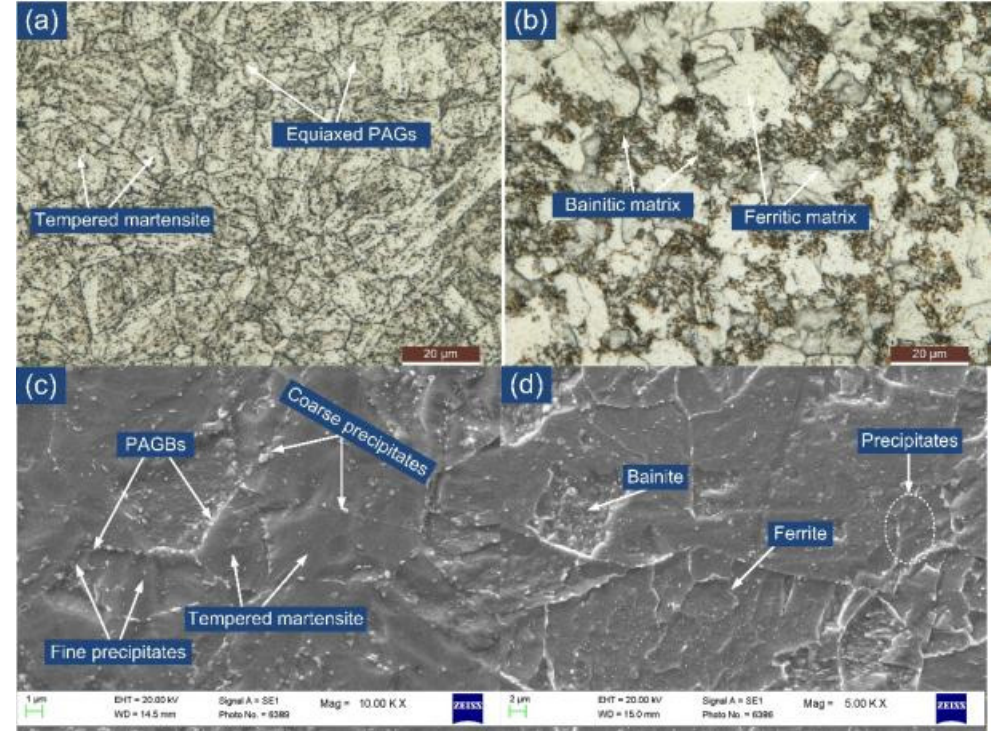
Figure 1. Typical optical image of ( a ) P22 steel, ( b ) P91 steel; SE image of ( c ) P22 steel, and ( d ) P91 steel.